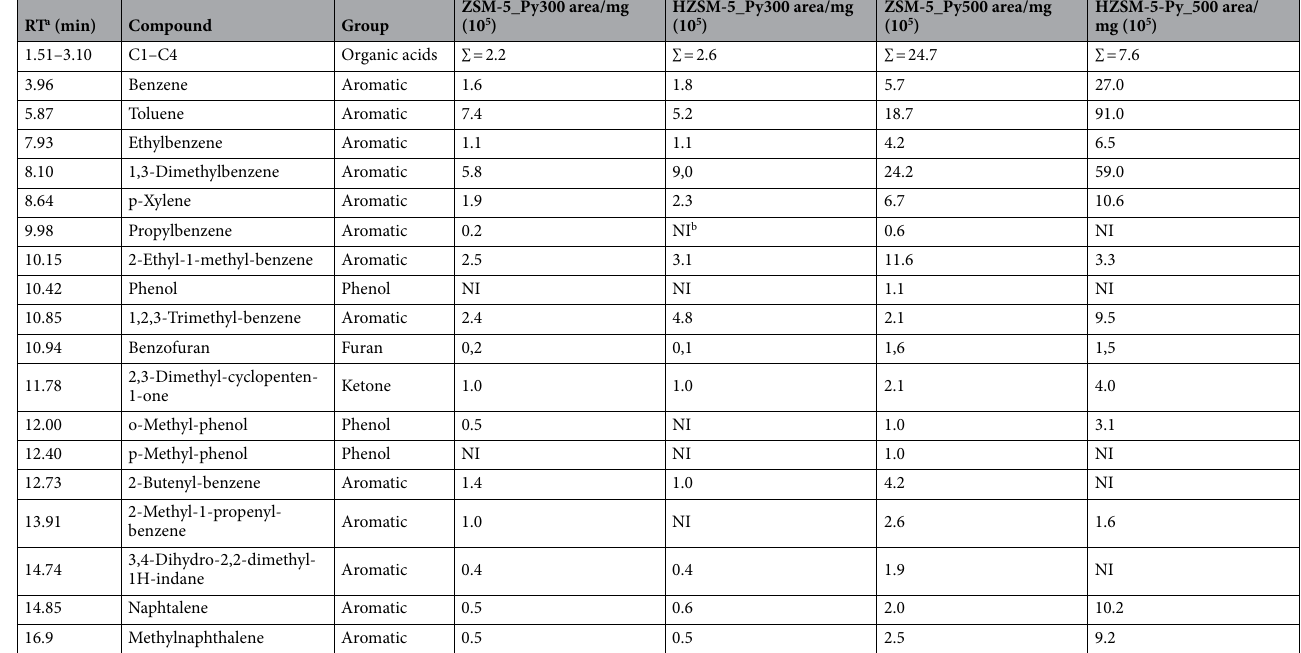
Table 5. Catalytic pyrolysis with ZSM-5 and HZSM-5 at 300 and 500 °C products